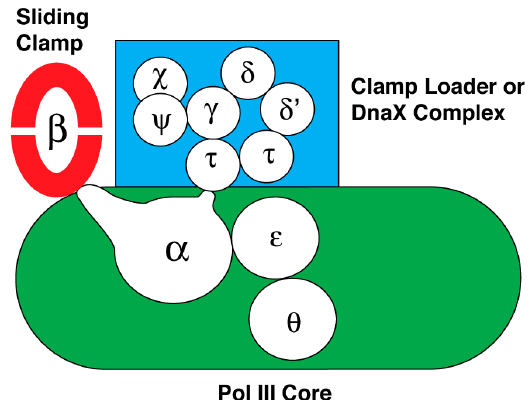
Figure 2. Subunit composition and their interactions of DNA polymerase III holoenzyme (reviewed in [207,218,224]). The subassemblies of DNA polymerase III holoenzyme are the sliding clamp composed of two DnaN or β subunits, the clamp loader or DnaX complex composed of seven subunits, and DNA polymerase III core containing the α , ε and θ subunits. The diagram also summarizes how these subunits interact within each subassembly and between subassemblies.